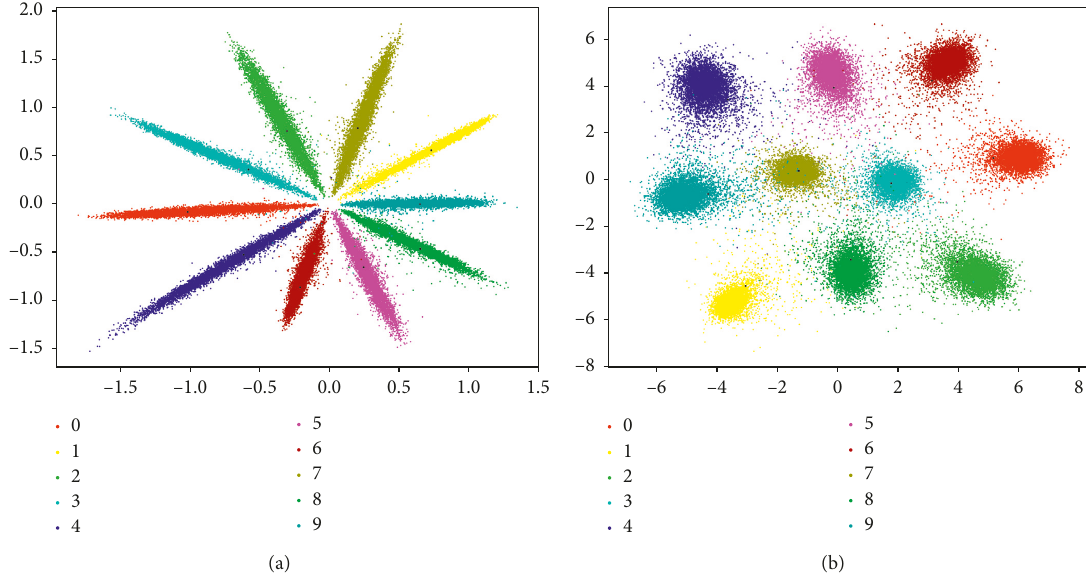
Figure 4: The distributions of the features trained using GO loss (a) λ The contribution of radial loss and tangential loss to the overall GO loss is shown. Best viewed in color.